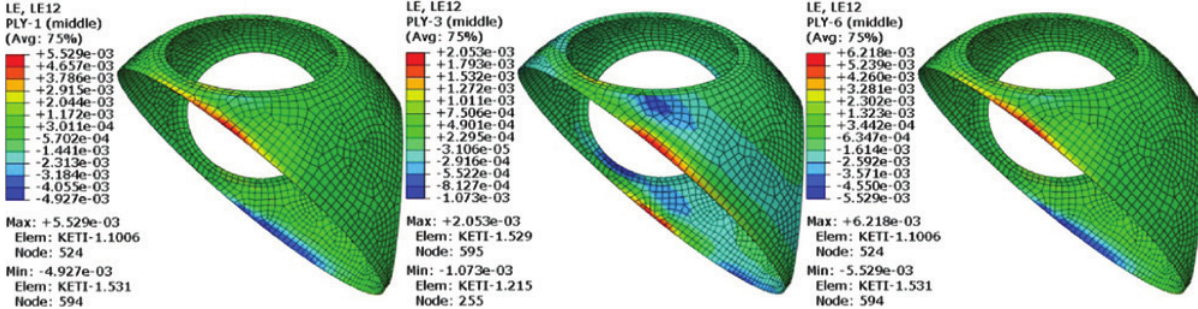
020406080100120140